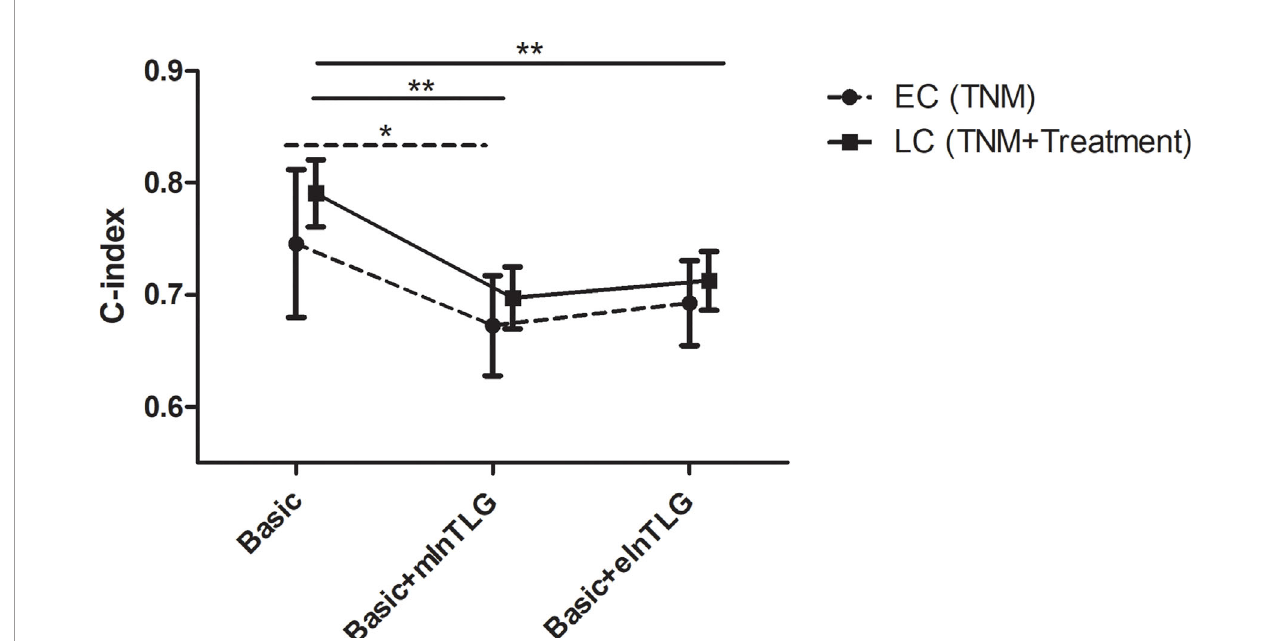
FIGURE 4 | C-index in 95% CI before and after integrating mlnTLG or elnTLG. The variables of basic models for lung cancer (LC) or esophageal cancer (EC) patients are separately determined by the multivariate Cox regression (in the brackets). The signi fi cance between each two C-index is indicated by *P < 0.05 or **P <